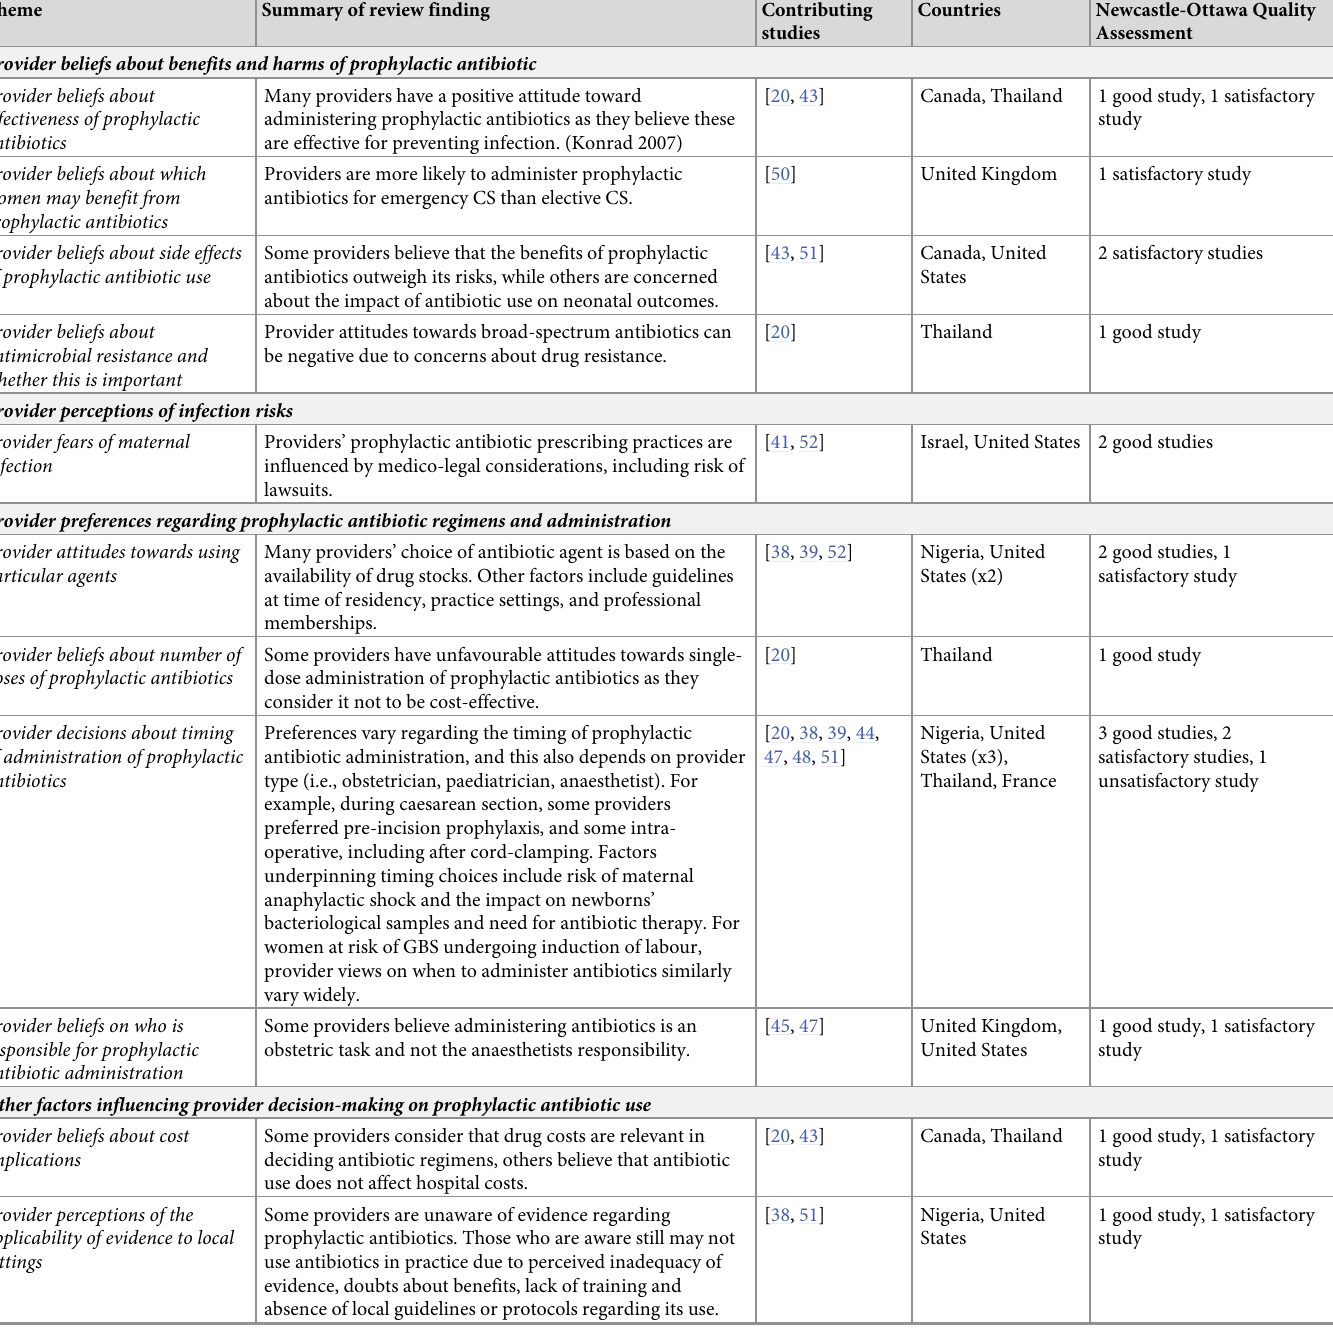
Table 3. Summary of findings from quantitative evidence on perspectives and experiences of women and healthcare providers on use of peripartum prophylactic antibiotics.